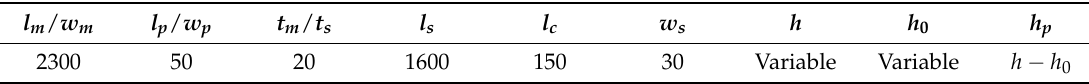
Table 1. Main geometric parameters of the micro-switch ( µ m).